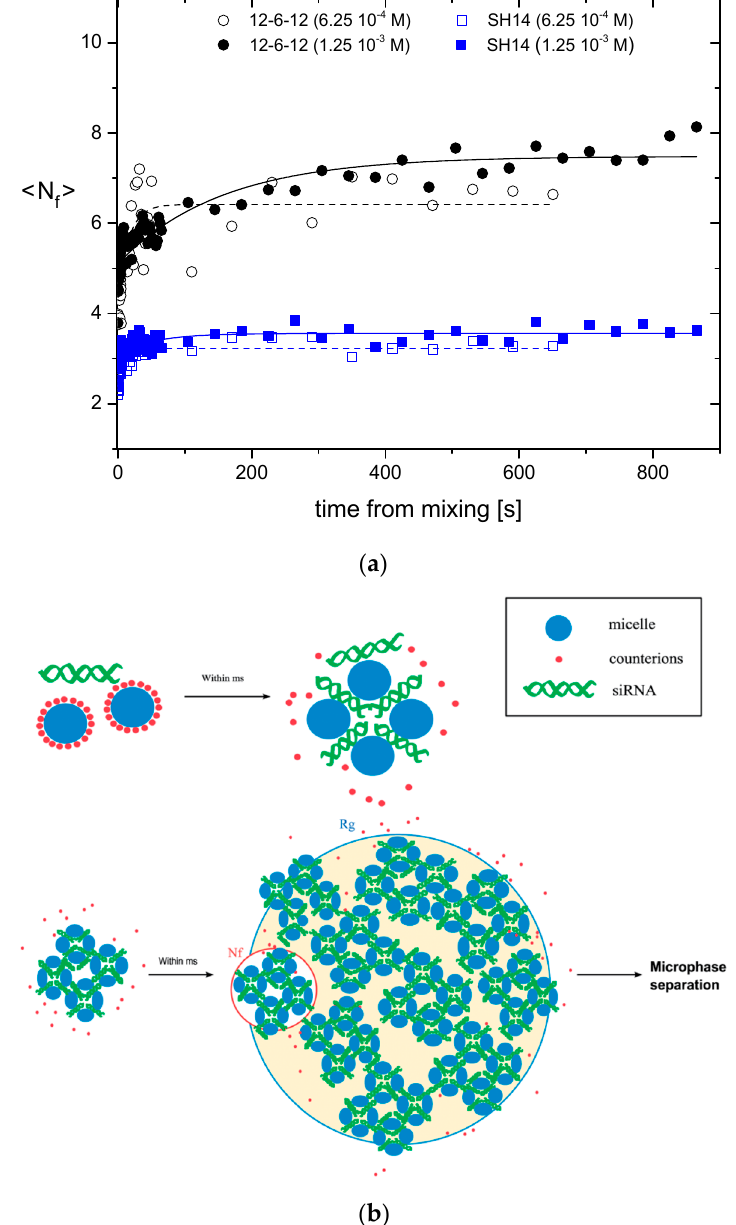
Figure 5. ( a ) Time evolution of the number of correlated layers in small interfering RNA (siRNA)/micelle complexes for surfactants 12-6-12 and SH14 at two different concentrations, for charge ratio CR = 1.25. ( b ) Schematic of the pathway of complex formation. (Reproduced from [56]. Copyright RSC 2014 ).